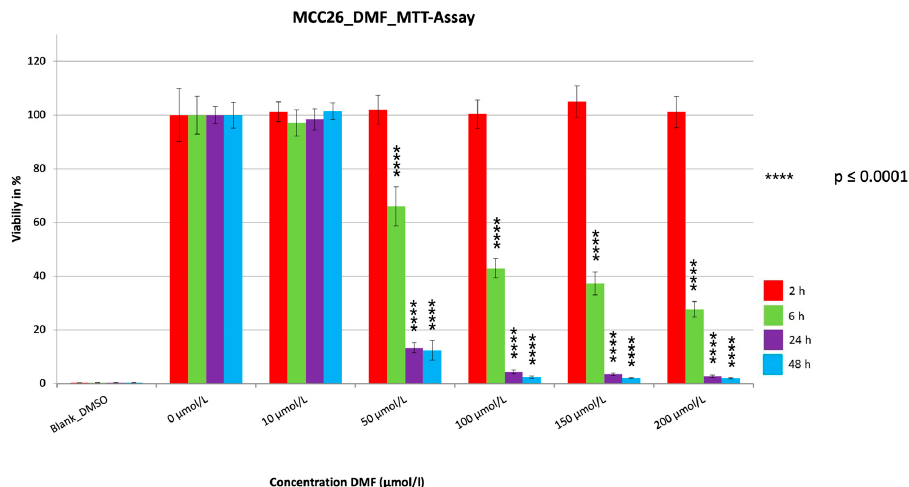
Figure 3. MTT measurement of the cell line MCC26 with a cell concentration of 50.000 cells/well with the addition of the substance DMF in different concentrations (10–200 µmol/L). Values are expressed as the mean ± SD of eight technical replicates. A multiple comparison test following the ANOVA was used to test whether there were significant differences between the individual mean values and the mean value of the normal